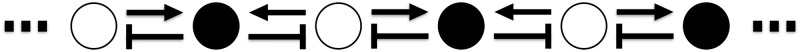
Simplest connectivity matrix A.A finite line of excitatory and inhibitory neurons. White nodes represent excitatory neurons. Black nodes are inhibitory. All connections have strength of the same magnitude.